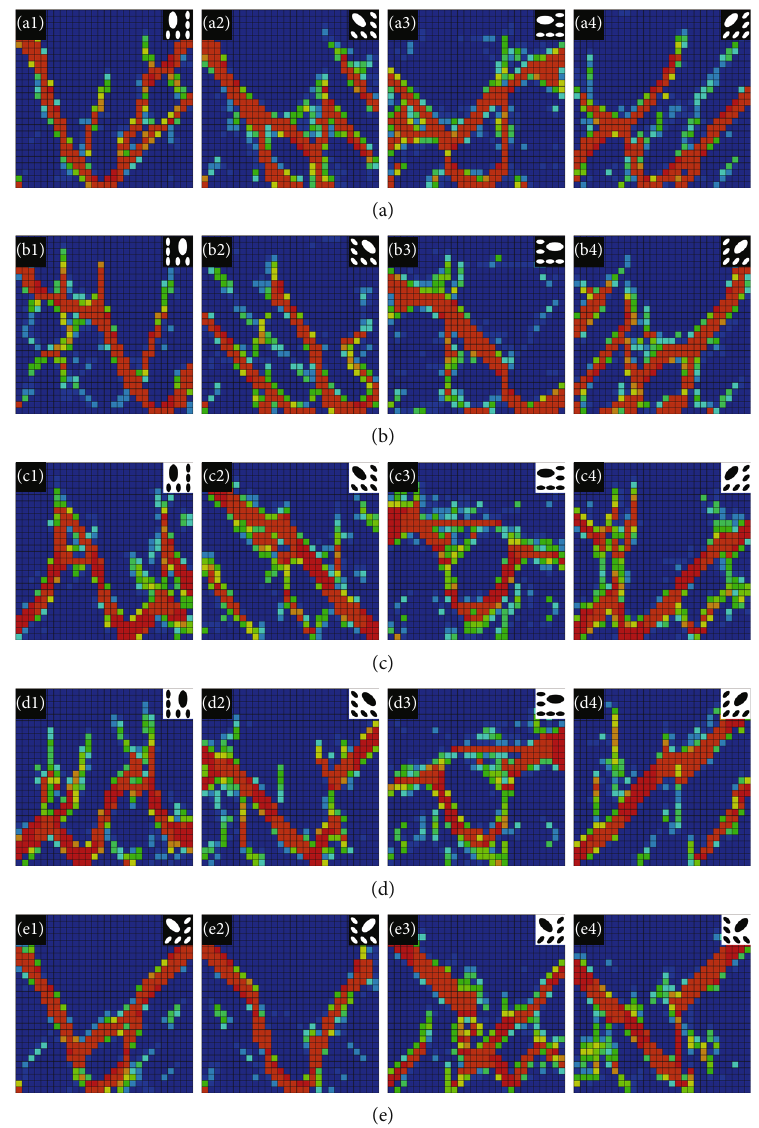
Figure 13: Compressive damage at the beginning of the residual stage ( ε = 0 : 01 ) of the structures with consistent inclusion inclination but di ff erent grain sizes and included